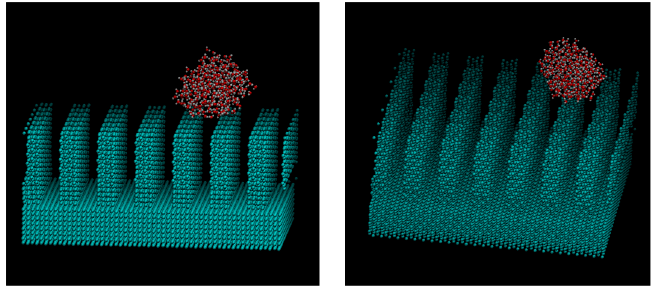
Figure 11. Snapshot of water molecules during the condensation on the ε = 0.06168. kJ/mol surface from the different viewpoints. The water droplet did not enter the nanostructure.